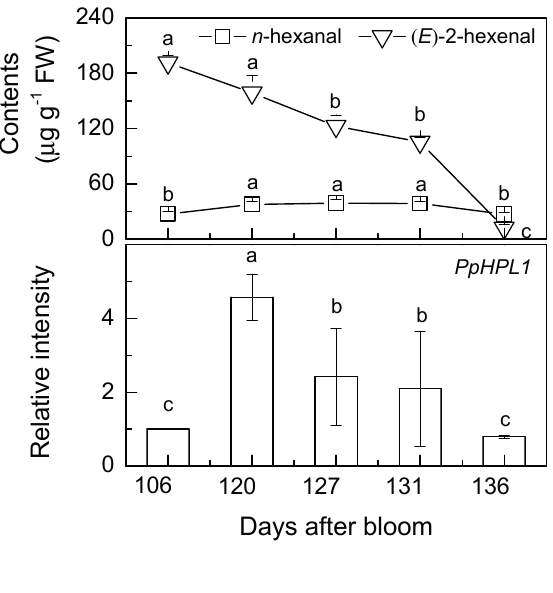
Figure A1. Changes in n -hexanal, ( E )-2-hexenal contents, and PpHPL1 expression levels of peach fruit skin during maturation. Mean value of three replicates is shown with standard error, and different letters above the symbols indicate significant differences (LSD,